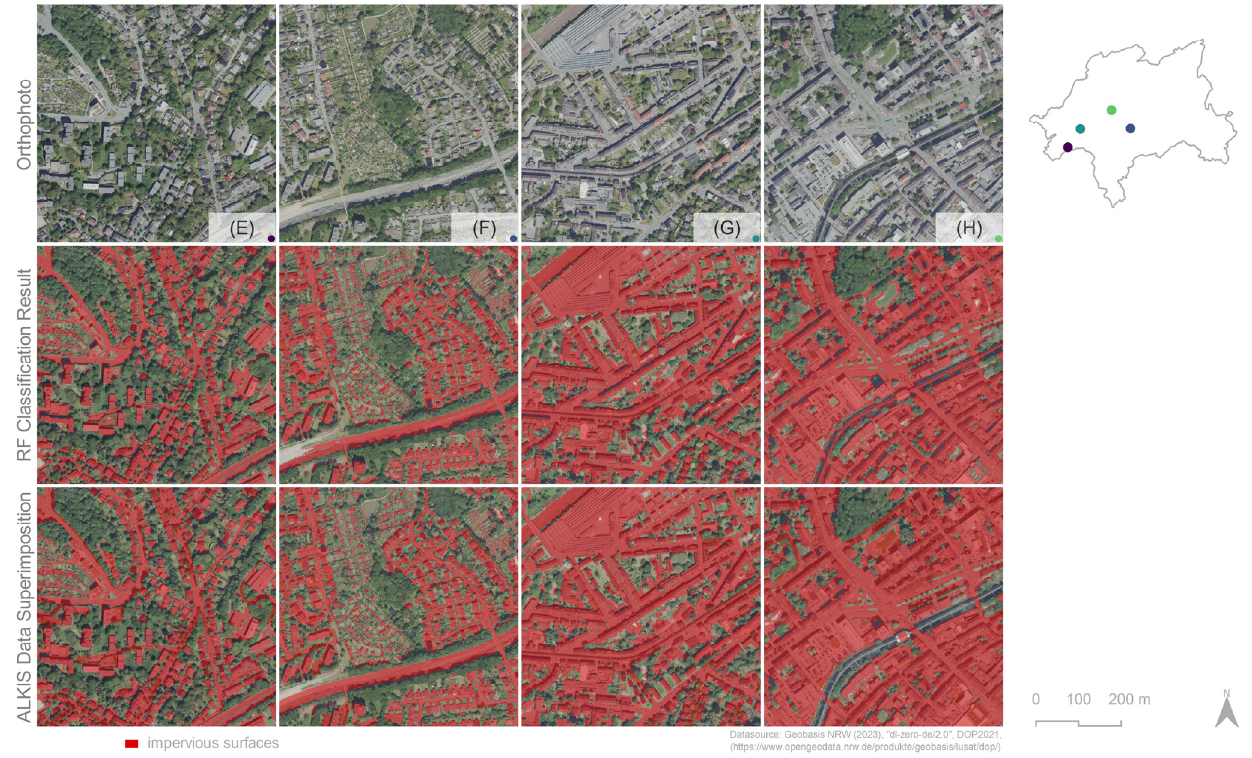
Figure 10. Comparison of RF classification results and data superimposition results in semi-urban to urban settlement areas: allotments between residential areas (E,F), high-density urban areas (G,H).